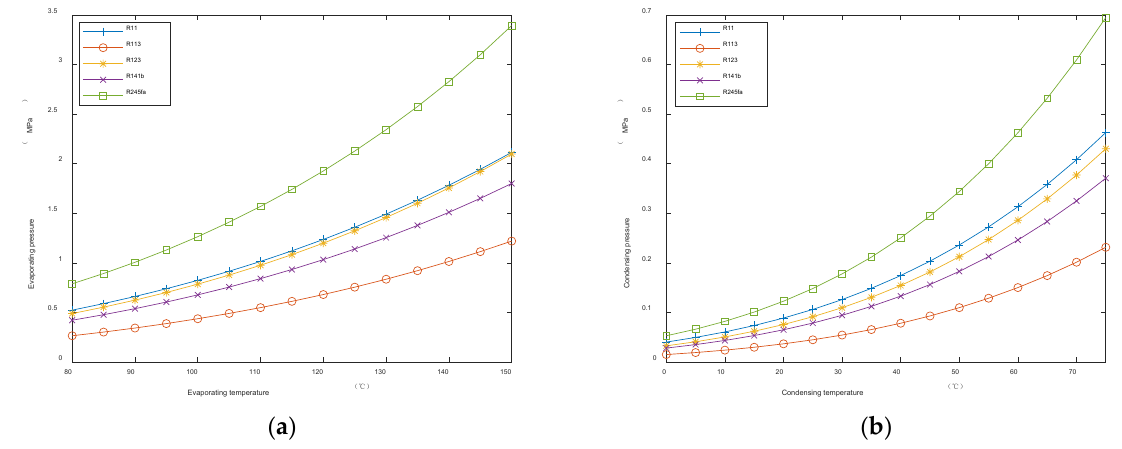
Figure 7. Relationship between the pressure and temperature of different organic working media. ( a ) Variation of evaporation pressure and evaporation temperature of different organic working fluids. ( b ) Variation of condensation pressure and temperature for different Organic Working Fluids.